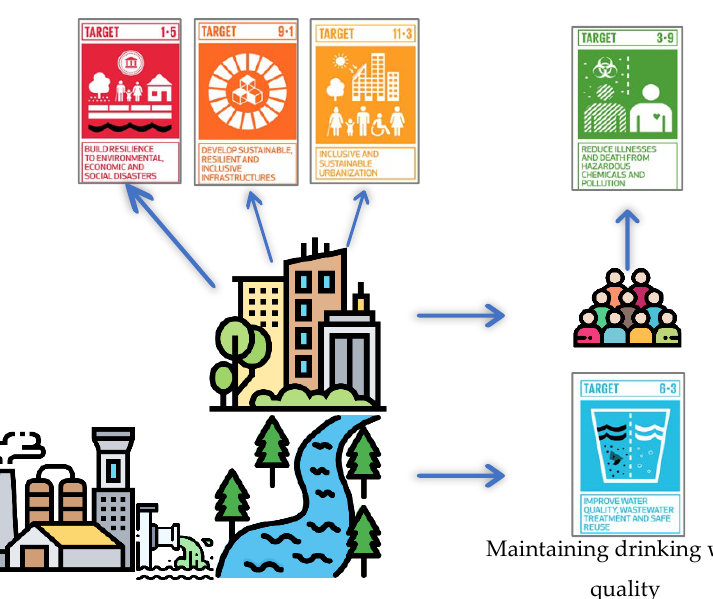
Figure 2. The relation between SDGs and maintaining drinking water quality [16–19].